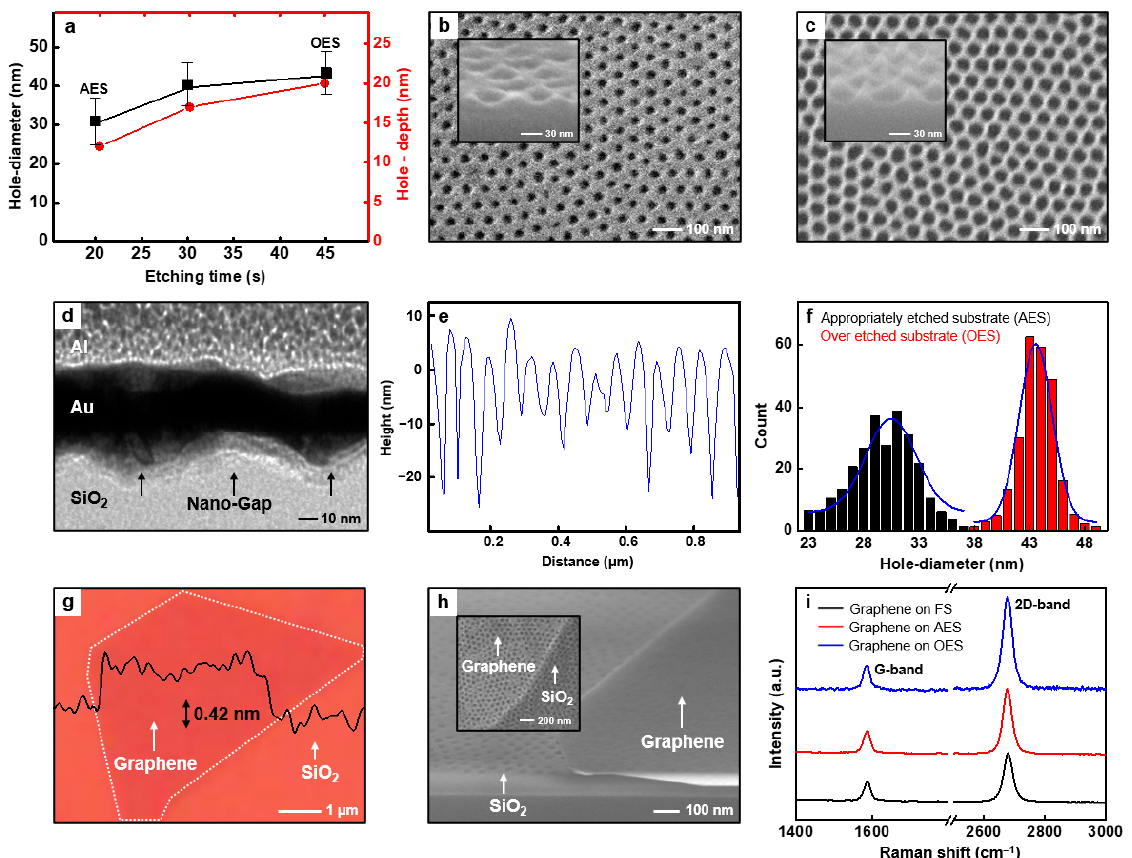
Figure 2. ( a ) A graph for hole diameter/depth vs. etching time. Top view SEM images of ( b ) appropriately etched substrate (AES) and ( c ) over etched substrate (OES). ( d ) A TEM image and ( e ) cross ‐ sectional profile of OES. ( f ) Column chart of hole diameter vs. count of number of holes on the AES and OES in 1 μ m 2 area. ( g ) An OM image and cross ‐ sectional profile of transferred monolayer graphene onto flat silicon oxide substrate (FS, thickness of graphene = 0.42 nm). ( h ) Tilted & top view scanning electron microscope (SEM) images of transferred graphene onto AES during G ‐ FETs fabrication. ( i ) Raman spectra of monolayer graphene on FS, AES, and OES.